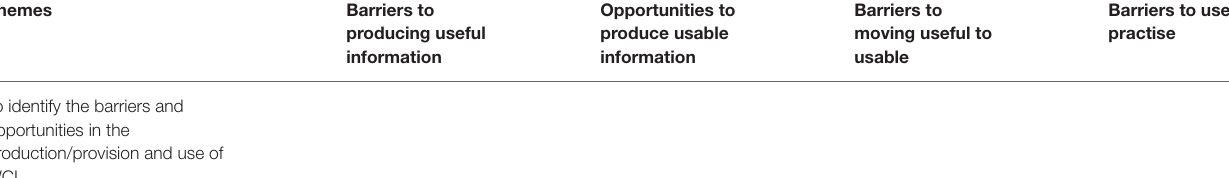
TABLE 2 | Categorisation matrix showing the themes used in the coding of data in Nvivo.